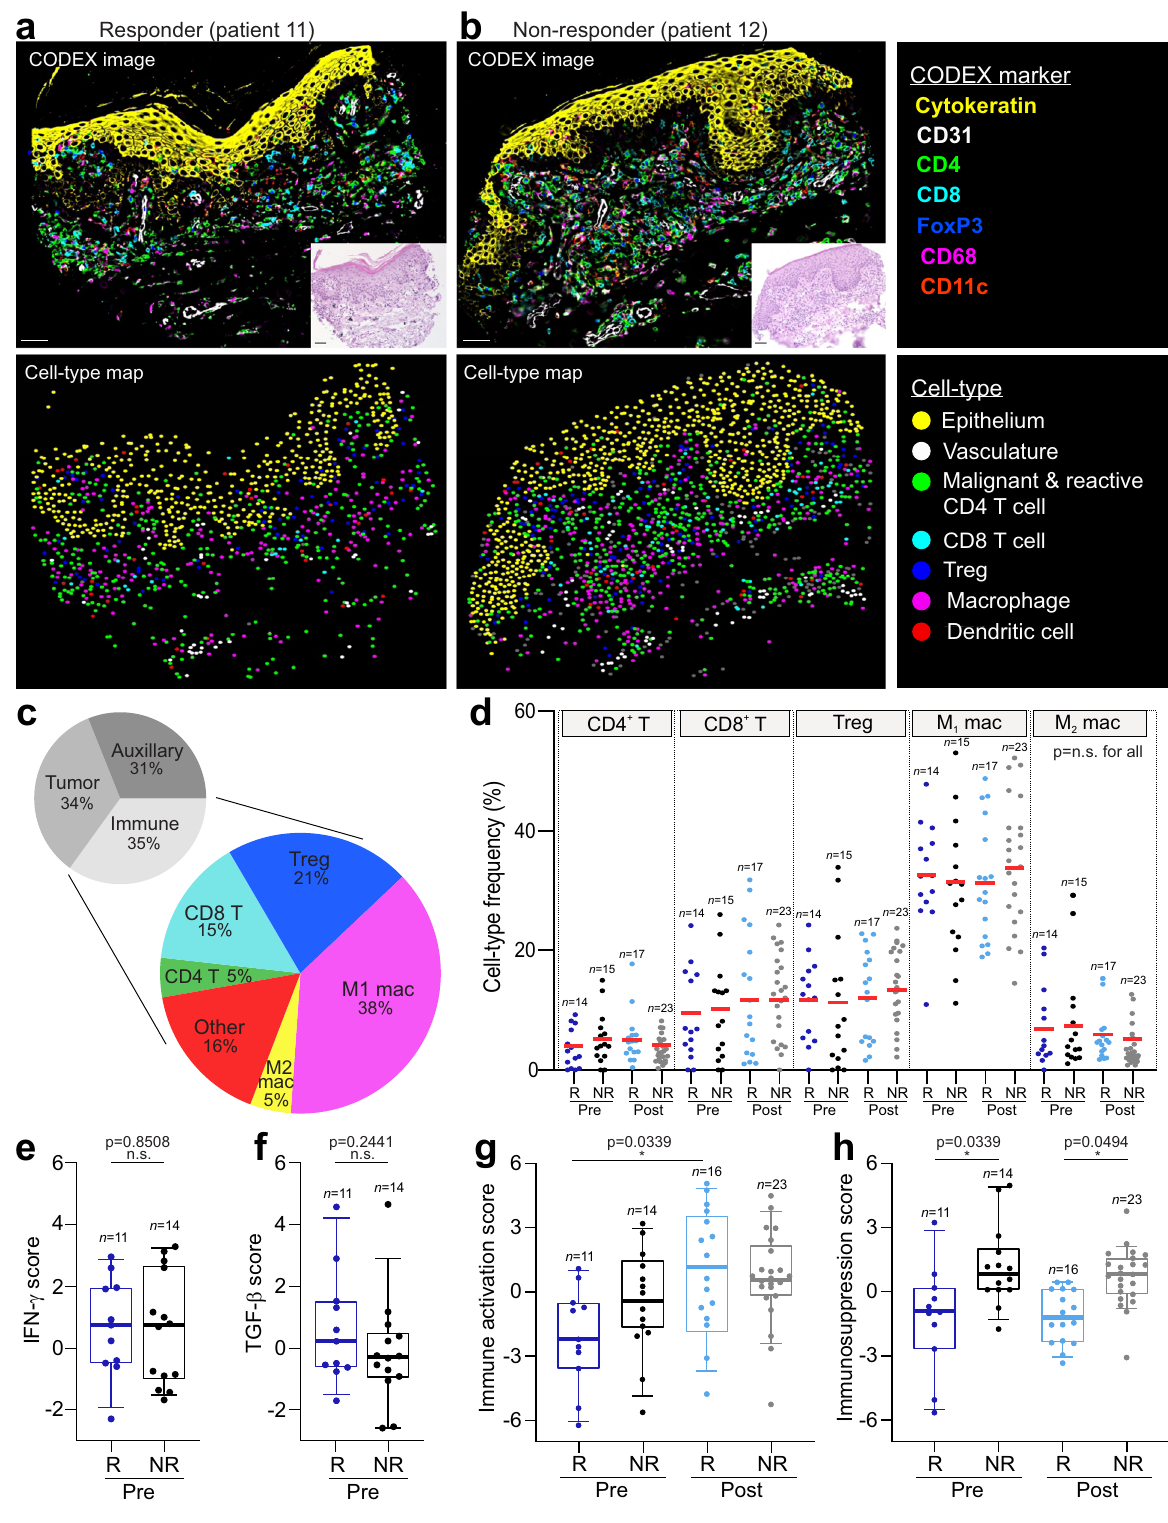
correlation of CNs and cell types are represented as a heatmap (Fig. 3a.3). CNs are visualized as Voronoi diagrams and ana- lyzed to better understand cellular spatial behavior (Fig. 3a.4). Importantly, these Voroni diagrams account for the spatial interactions between different cell types and as such provide a layer of information beyond the cell type maps shown in Fig. 2a, b. NATURE COMMUNICATIONS| (2021) 12:6726